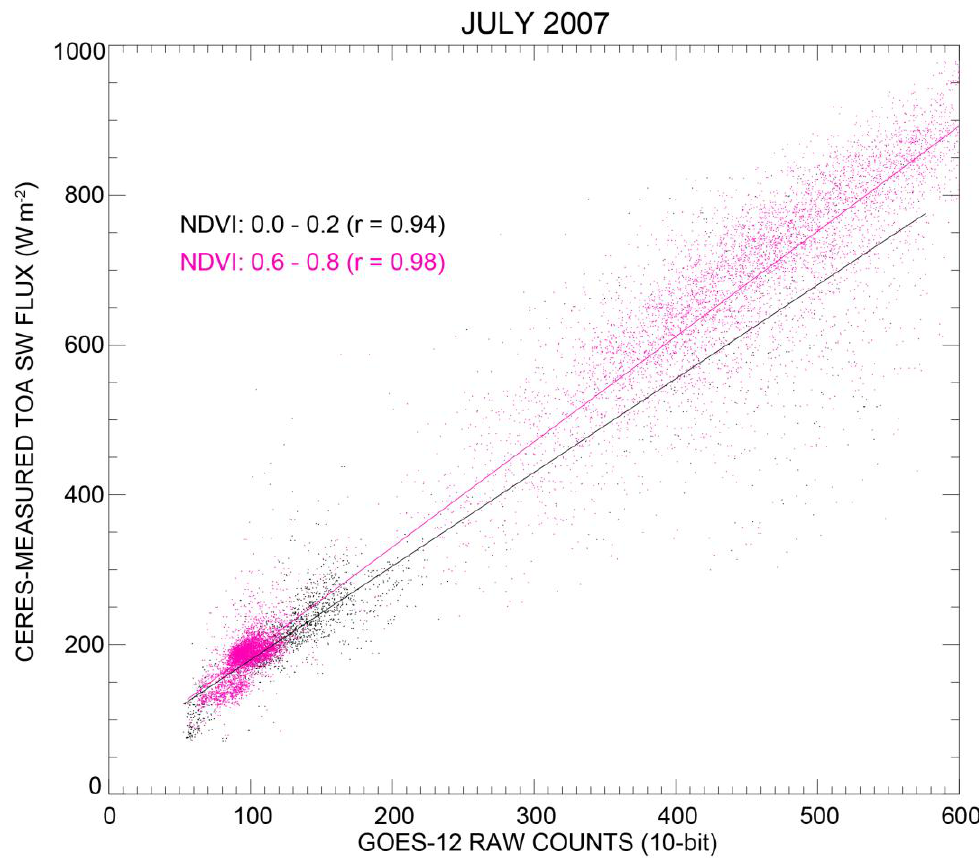
Figure 2. Matched pairs of GOES-12 raw counts (abscissa) and Clouds and Earth’s Radiant Energy System (CERES)-measured TOA shortwave (SW) flux for July 2007 for two different Normalized Difference Vegetation Index (NDVI) intervals. Pearson’s Correlation (r) value obtained between satellite data are